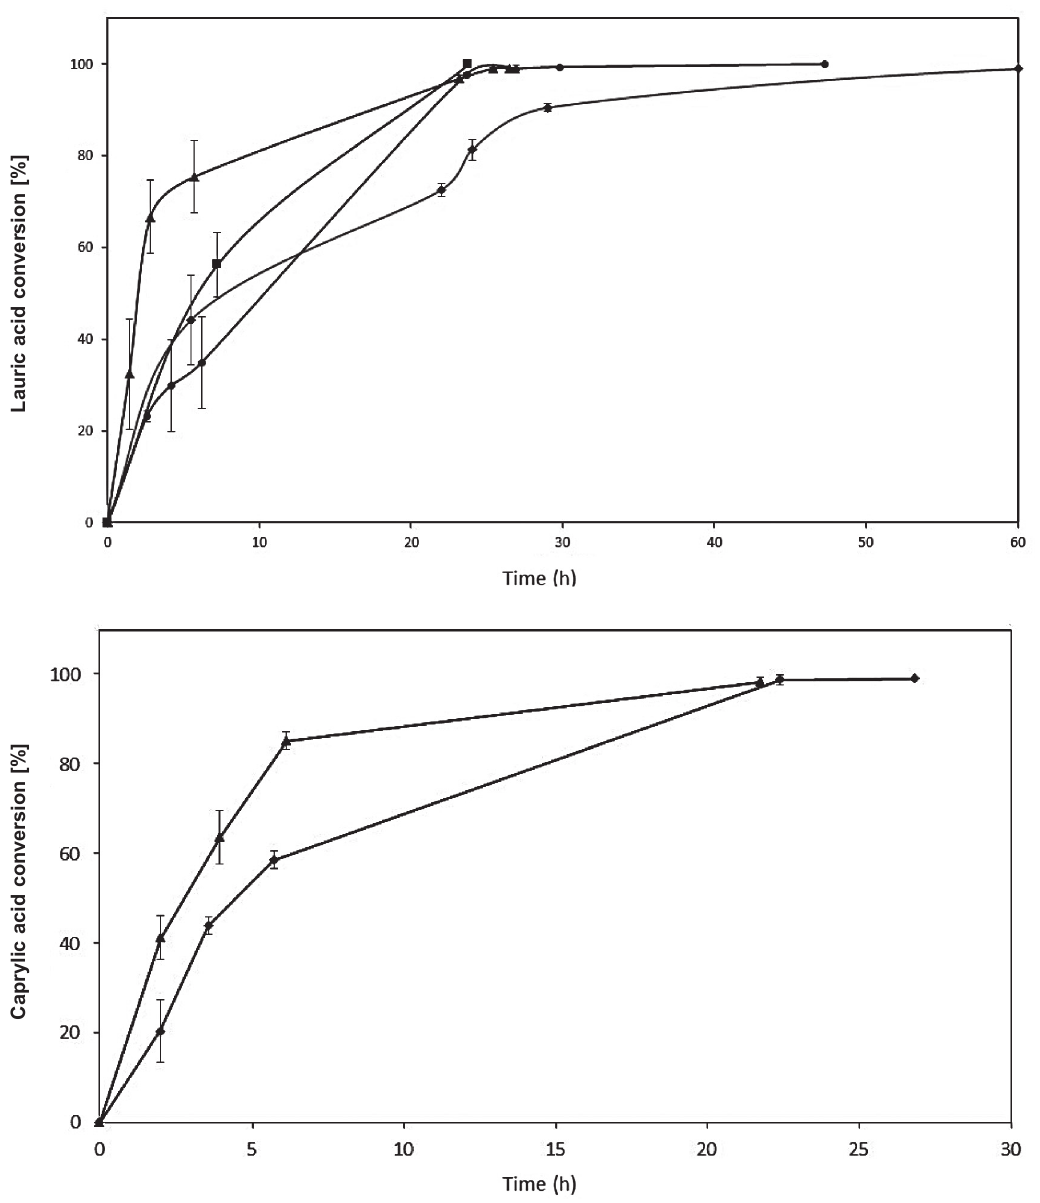
Fig. 5 – (a) Conversion of lauric acid at 1:1 (  ), 1.5:1 (●), 2:1 (▲) and 3:1 (■) at various PG-10 and LA weight ratio (b) conversion of caprylic acid at 1:1 (  ), and 2:1 (▲) PG-10 and CA weight ratio using N ing for water removal in cylindrical glass